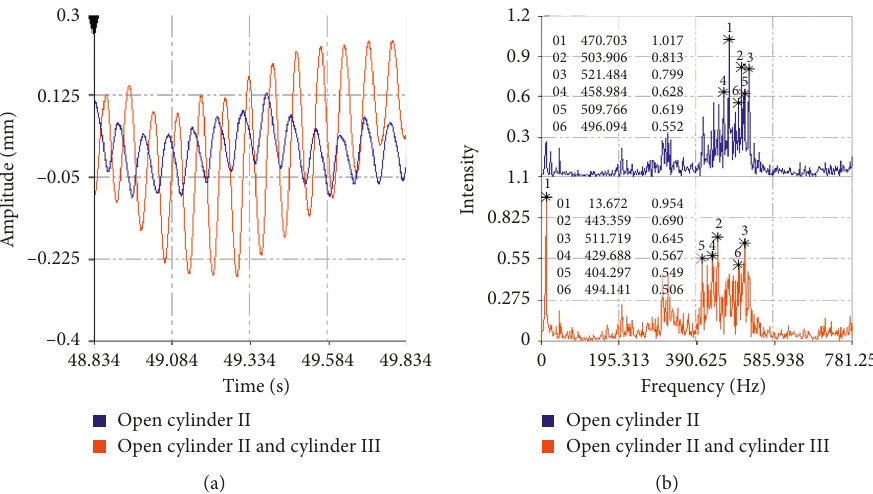
Figure 12: Vertical displacement of the bearing housing of cylinder II in 1 s. (a) Time-vertical displacement curve in 1s. (b) Time-frequency spectrogram.